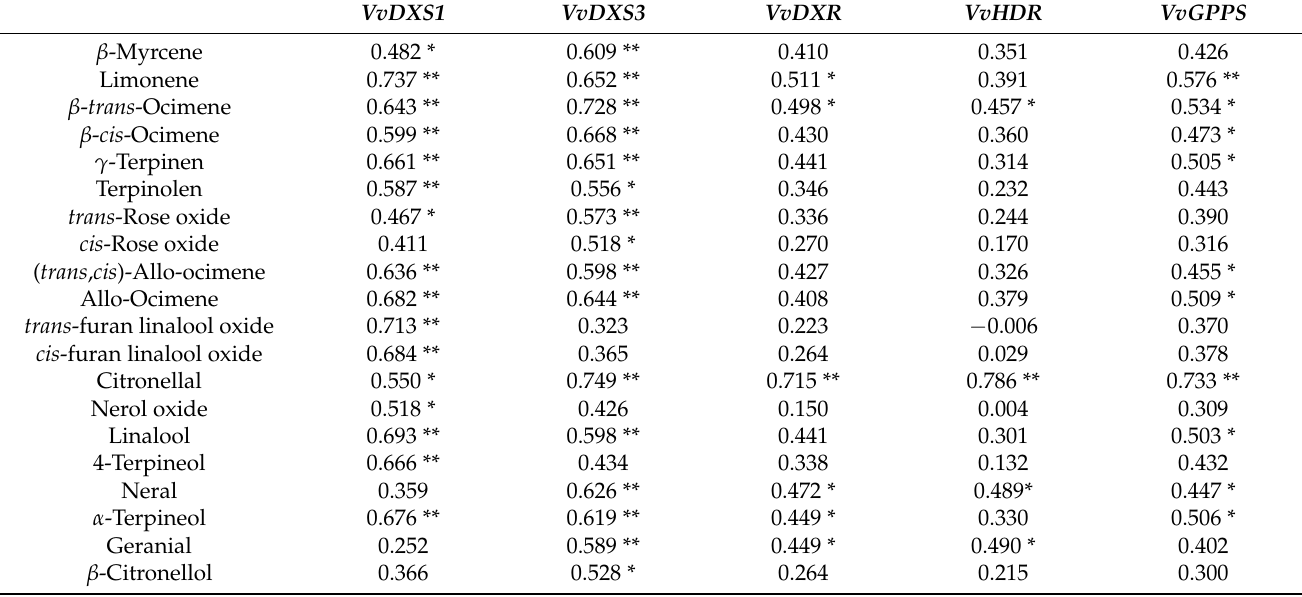
Table 4. Pearson’s correlation between terpene volatiles and MEP pathway gene expression in seven table grape